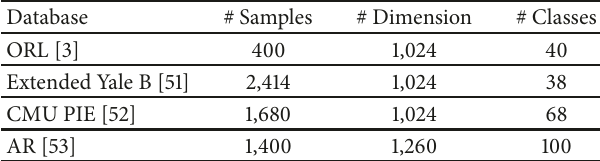
Table 2: Description of the datasets used in the